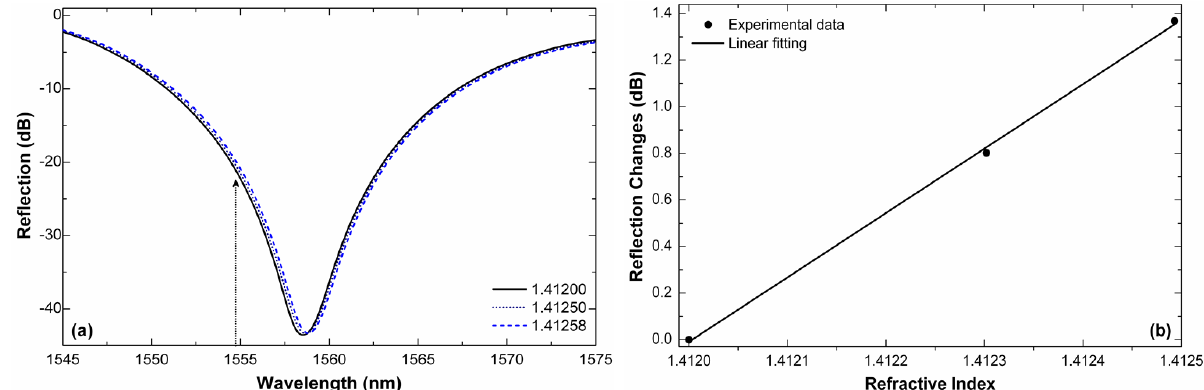
Figure 5. ( a ) Reflection spectra for three RI values that are closed to each other. ( b ) Reflection changes observed at λ = 1,554.8 nm as a function of the external RI. The interferometer was 12 mm